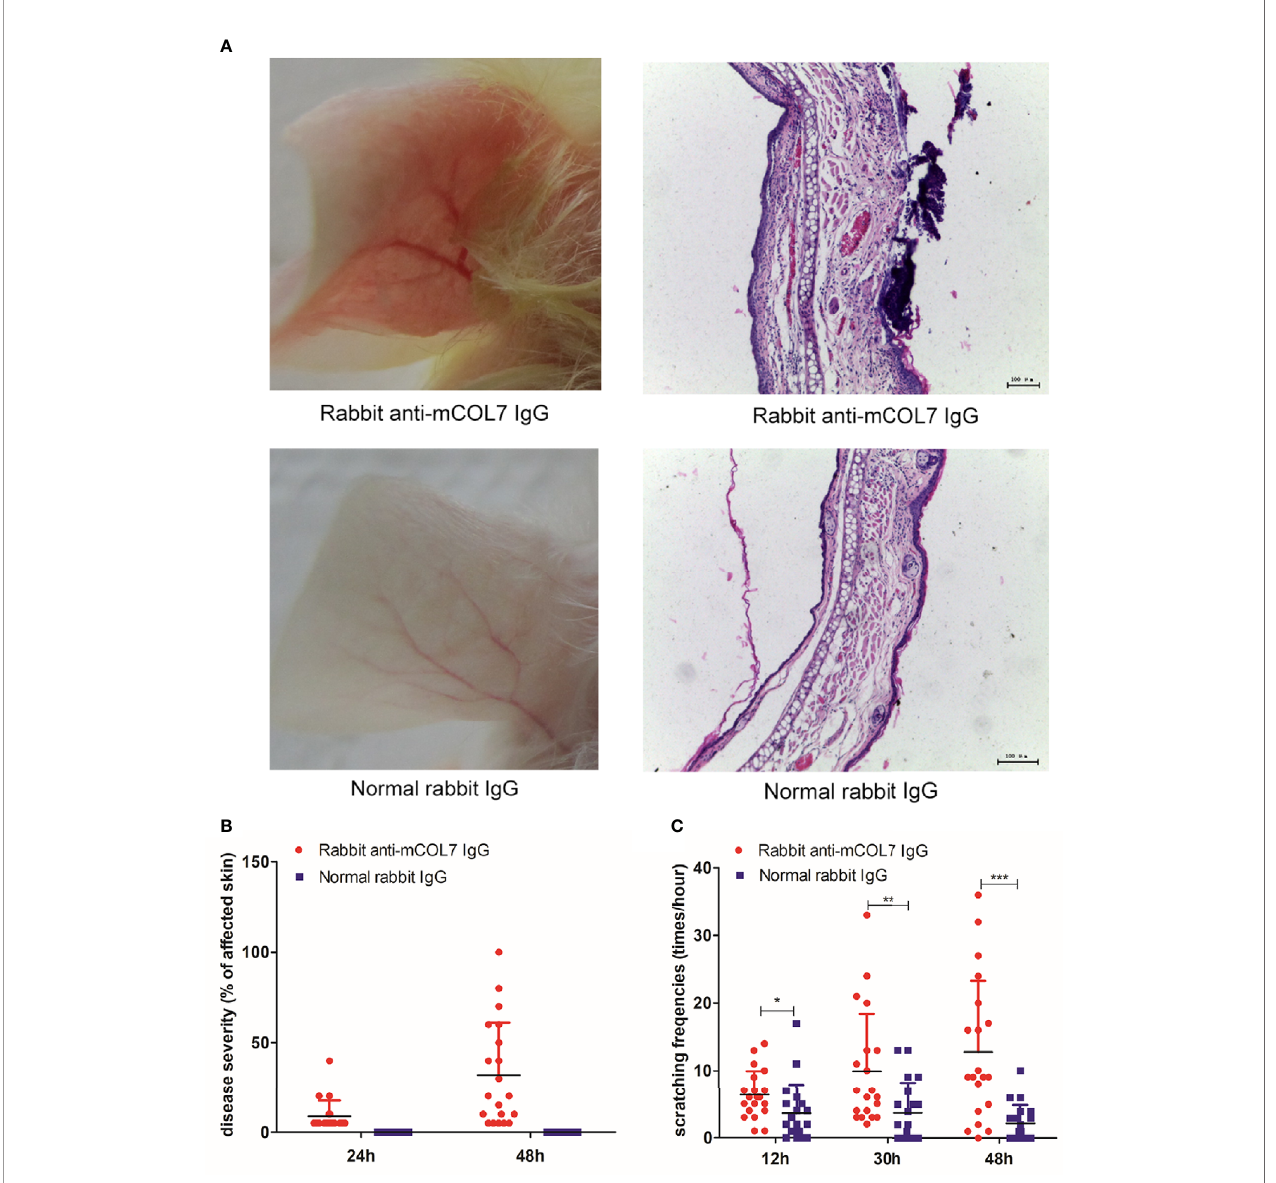
FIGURE 1 | Injection of anti-mCOL7 IgG promotes the frequency of scratching. Female Balb/c mice were injected with 0.5 mg rabbit anti-mCOL7 IgG or control rabbit IgG i.d. into ear skin, and disease severity as well as frequency of scratching was evaluated. (A) Representative pictures of ear skin lesions and histology of ear skin of mice treated with rabbit anti-mCOL7 IgG or control rabbit IgG. Histological analysis was performed 48 hours after fi rst antibody injection using H&E staining. (B) Mice were scored at 24 and 48 h after the antibody injection, the severity of the disease was measured as the percentage of affected ear skin. (C) Scratching behavior was quanti fi ed at 12, 30 and 48 h after the antibody injection, and the scratching frequency was presented as times of scratching per hours. Data are derived from 2 independent experiments each performed with 5 mice (10 ears) per experimental group. Bars, 100 m m. Signi fi cant differences as determined by unpaired student t-test between anti-mCOL7 IgG-treated ears and control IgG-treated ears are indicated (* p < 0.05, ** p < 0.01, *** p <